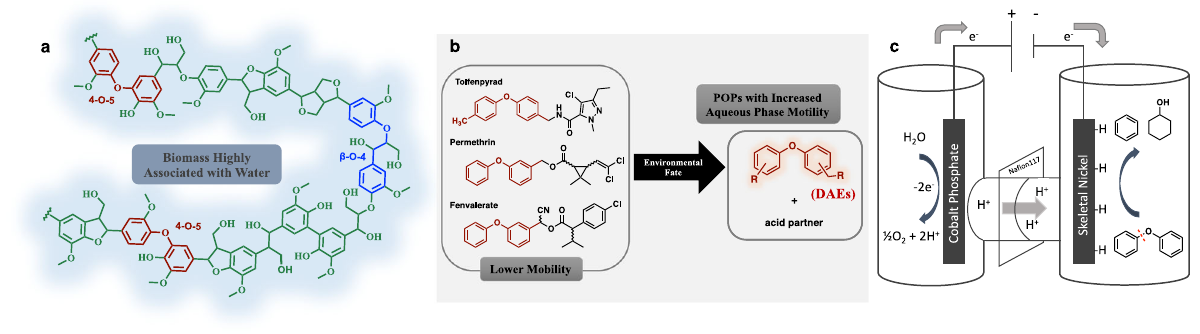
Fig. 1 Occurrence of diaryl ethers and schematic representation of their cleavage via electrocatalytic hydrogenolysis (ECH). a Lignin structure, highlighting diphenyl ether linkage (4-O-5). b POPs with increased mobility from environmental degradation of widely used agrochemicals. c Schematic illustration of electrocatalytic hydrogenolysis/hydrogenation of diphenyl ether in an